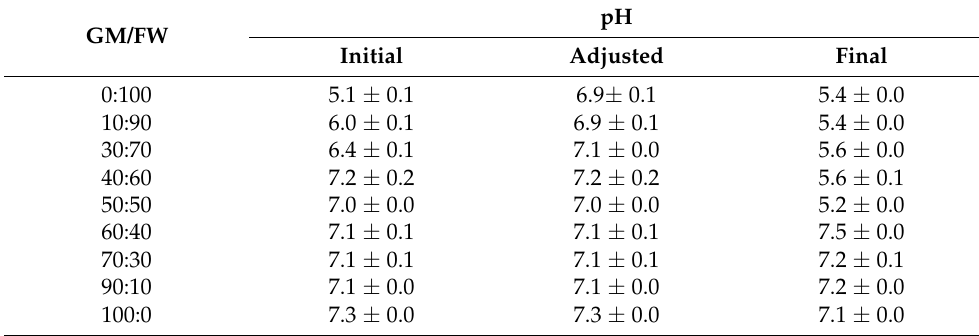
Table 5. Changes in pH for GM and FW mixing ratios during the 66 d